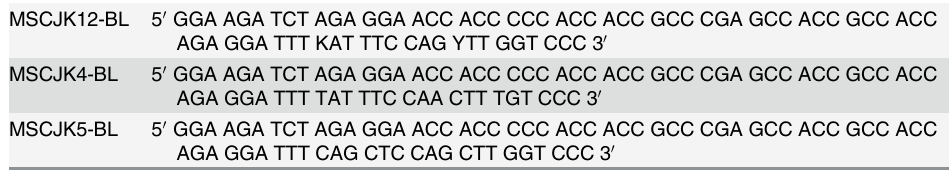
Table 3. V к chain 3 ’ primers for construction of a murine scFv library (pCOMB3xSS).